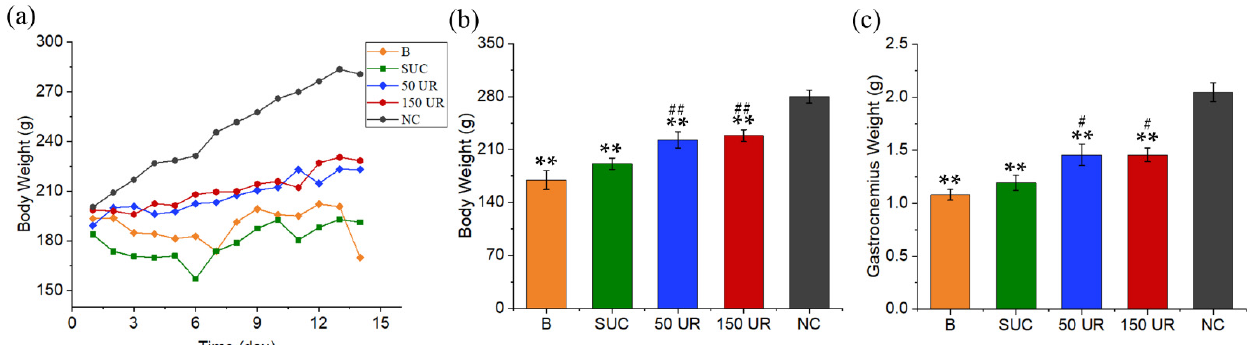
Figure 4. Body weight and gastrocnemius weight in a 14-day tail suspension test. ( a ) A 14-day continuous body weight change. ( b ) The body weights of the B, SUC, 50 UR, 150 UR, and NC groups on day 14. ( c ) Gastrocnemius weights of the B, SUC, 50 UR, 150 UR, and NC groups on day 14. The data are expressed as mean ± SE ( n = 5 in each group), ** p < 0.01 vs. NC group, ## p < 0.01 vs. B group, # p < 0.05 vs. B group.